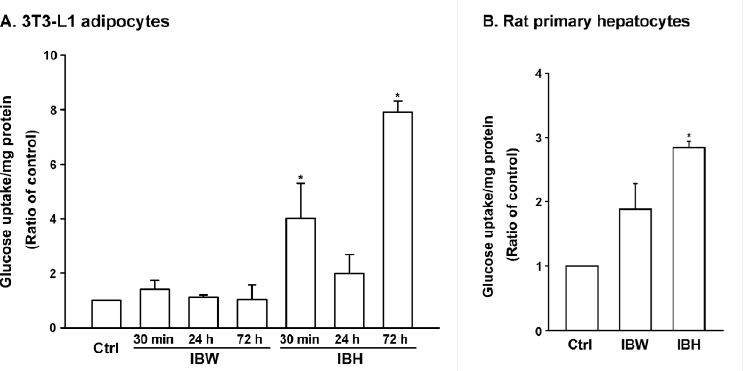
Figure 2. Glucose uptake test for IBH and IBW crude fractions. ( A ) Glucose uptake test in 3T3-L1 adipocytes: Differentiated 3T3-L1 adipocytes were treated with 0.1 mg/mL of IBW and IBH for 30 min,